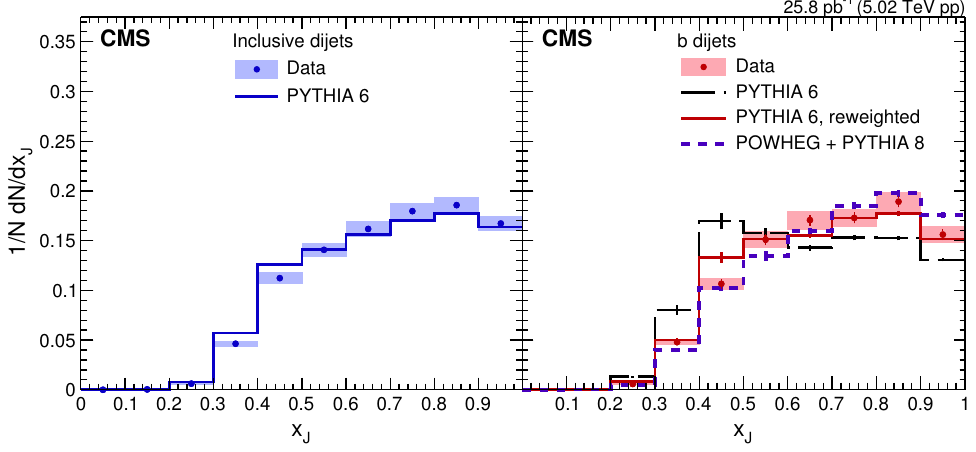
Figure 4 . Distributions of x J in pp collisions for inclusive dijets (left) and b dijets (right). System- atic uncertainties are shown as shaded boxes, while statistical uncertainties are shown as vertical lines. The data are compared to simulations performed using powheg and pythia , as described in the